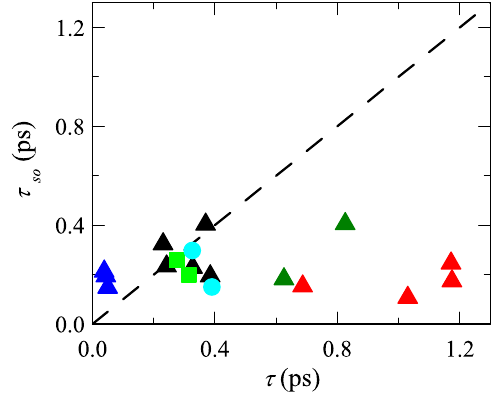
FIG. 6. Upper bound of τ , extracted from WAL data, as a so function of τ for monolayer graphene devices. The shape of the different symbols refers to devices realized on different TMD substrates (triangles for WSe 2 , circles for MoS 2 , and squares for WS 2 ). For each different symbol, data points represented with the same color refer to the same device measured at different gate ¼ τ voltages. The dashed line corresponds to τ so